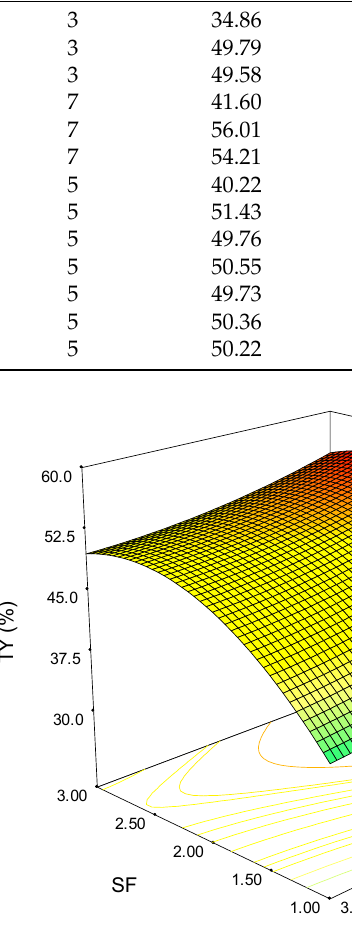
Figure 1. Variation of the total extraction yield as a function of severity factor and alkali concentration (the colours green-yellow-red indicate the shift from low to high values).